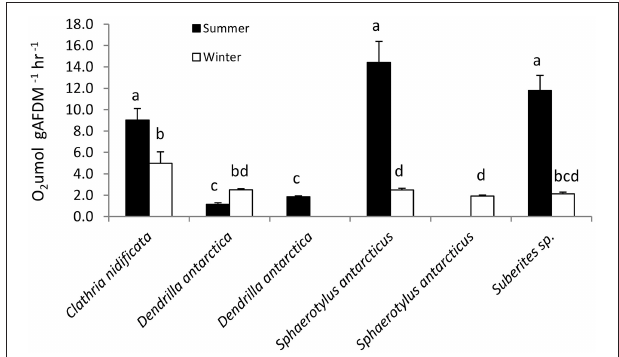
FIGURE 2 | Metabolic rate of sponge species in summer and winter. Values of oxygen consumption with same letter are not significantly different (Tukey tests, P < 0.05